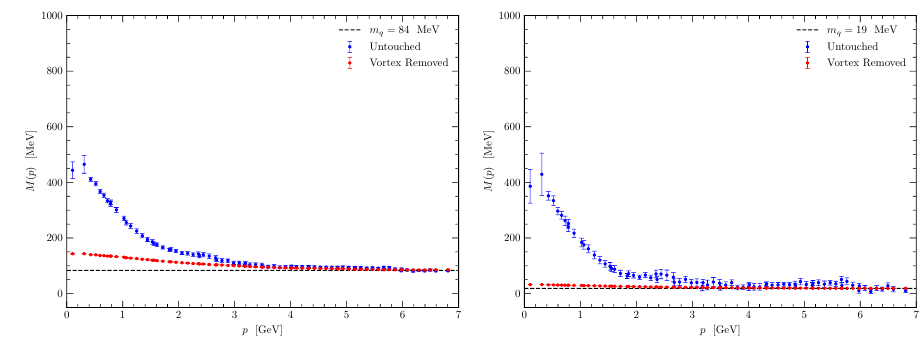
Figure 9. The mass functions, M ( p ), on untouched and vortex-removed dynamical-fermion ensembles for valence-quark masses m q = 84 MeV (left), and m q = 19 MeV (right). Explicit chiral symmetry breaking through the quark mass leaves a remnant of dynamical mass